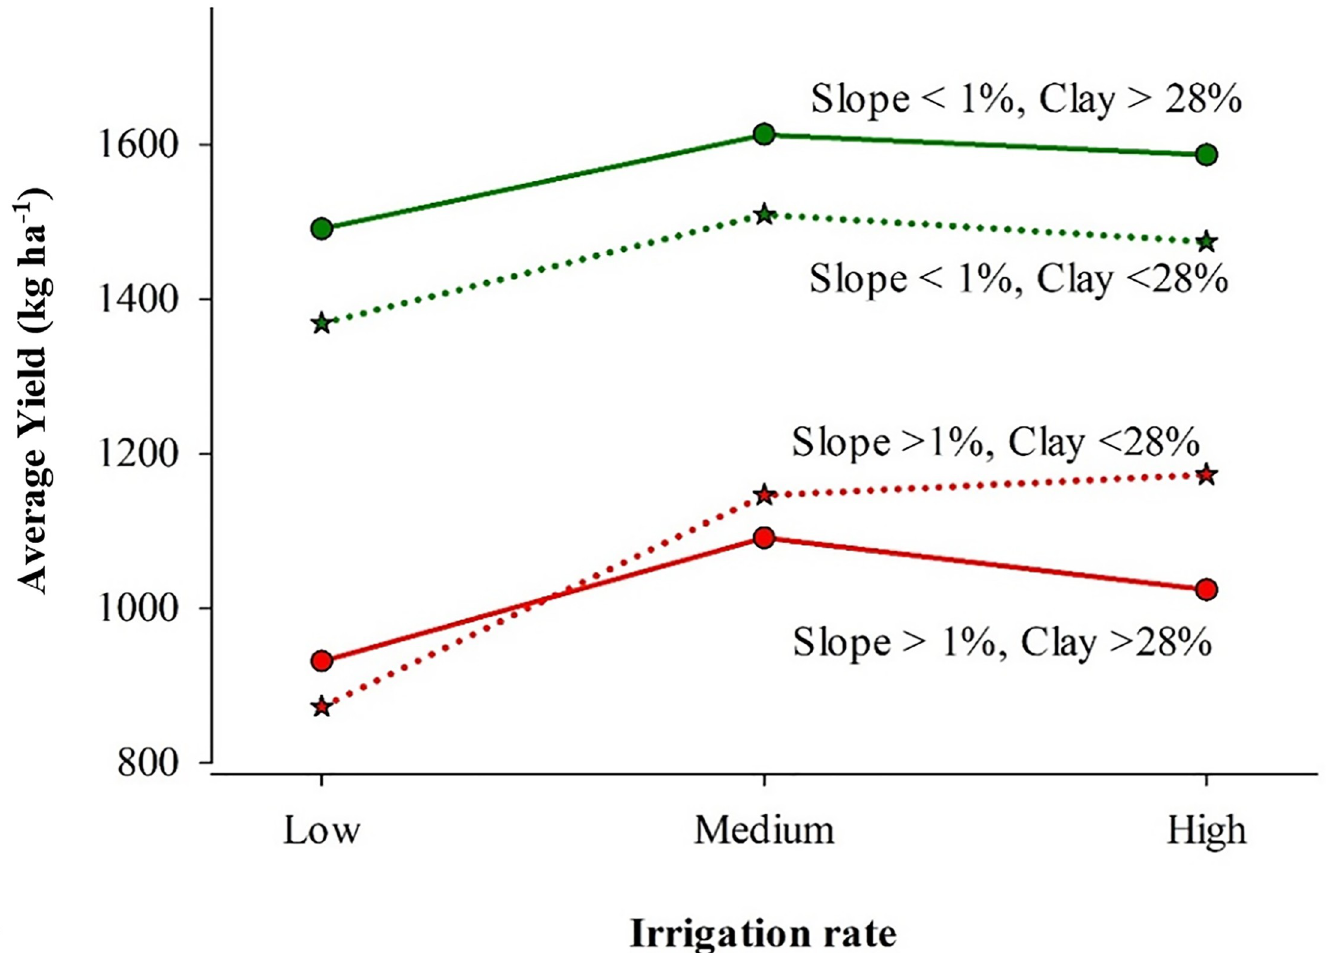
Fig 8. Interaction effects between irrigation rate, clay content, and slope on cotton lint yield in a 122-ha field in Hale County, Texas.